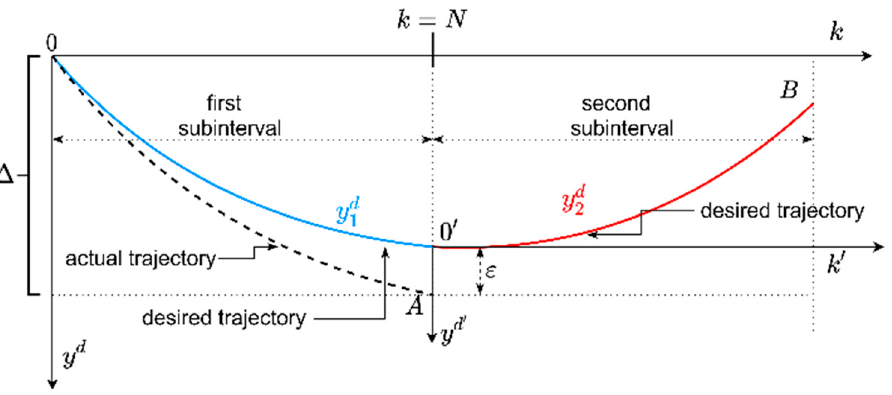
Figure 2. A trajectory consisting of two connected curves 00 ′ and 0 ′ 𝐵 ; moving the reference frame to 0 ′ makes the trajectory 0 ′ 𝐵 start in